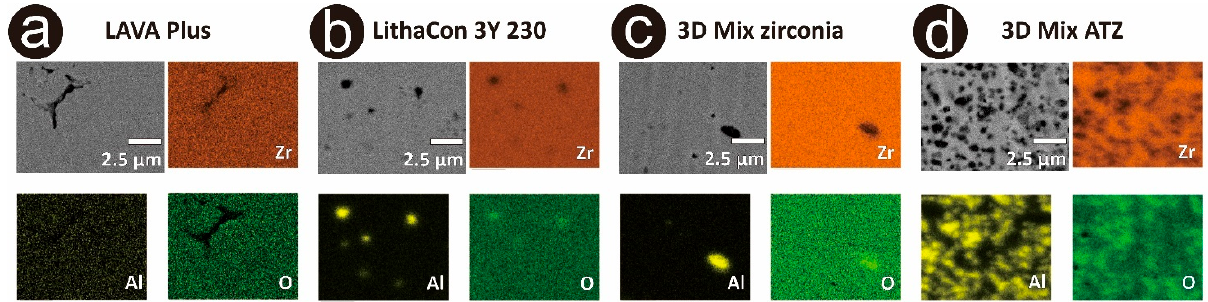
Figure 5. Representative FE-SEM photomicrographs and EDS maps of Zr, Al, and O. ( a ) subtractively manufactured 3Y-TZP (LAVA Plus, 3M Oral Care); ( b ) additively manufactured 3Y-TZP (LithaCon 3Y 230, Lithoz); ( c ) additively manufac-